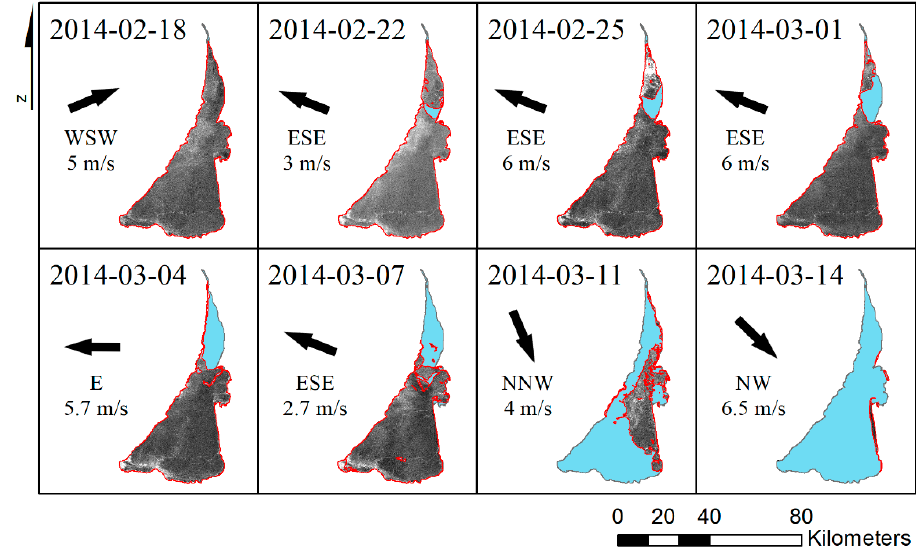
Figure 9. The ice cover retreat in the Curonian Lagoon in the winter of 2013–2014 under the prevalence of easterly and northerly winds. The red color indicates the ice cover boundary, the blue color shows water, the labels and arrows show the wind speed and direction.